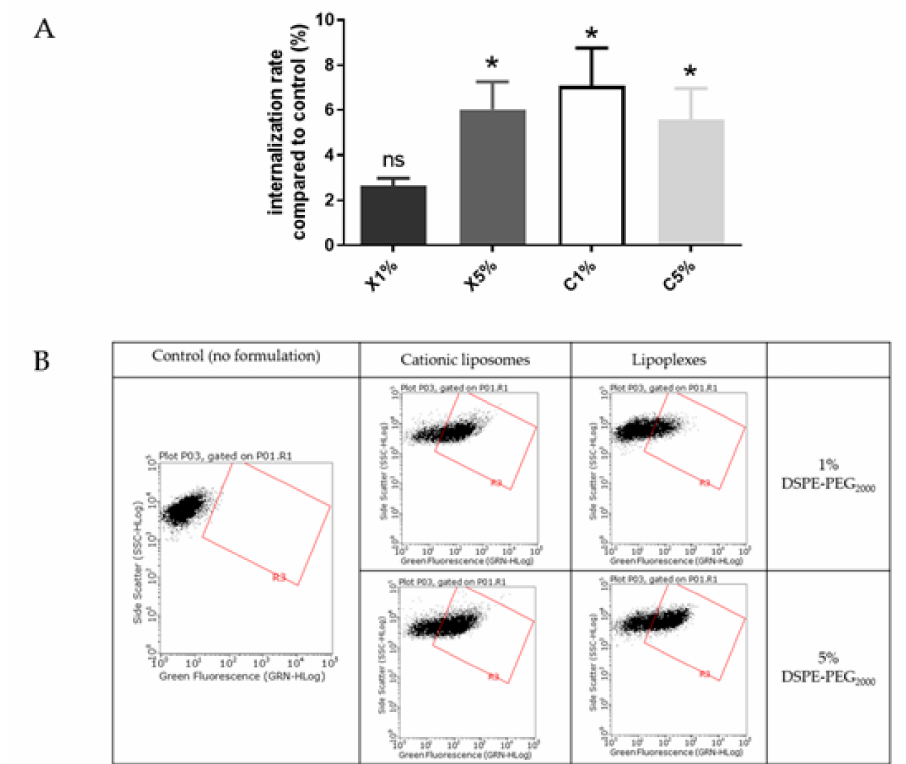
Figure 5. ( A ) Internalization study of cationic liposomes and lipoplexes (0.03 mM) containing 1% and 5% PEG. Internalization rates correspond to fluorescence from flow cytometry experiments relative to the control (cells incubated with medium only); data represent the mean ± SEM (n = 3); * indicates a significant difference compared to the control ( p < 0.01, Mann-Whitney); ( B ) Flow cytometry dot plots for liposomes internalization evaluation (green fluorescence, DOPE-NBD) after incubation with fluorescent cationic liposomes and lipoplexes (1 or 5 % PEG) at 0.03 mM for 4 h. A minimum of 15,000 cells/samples were